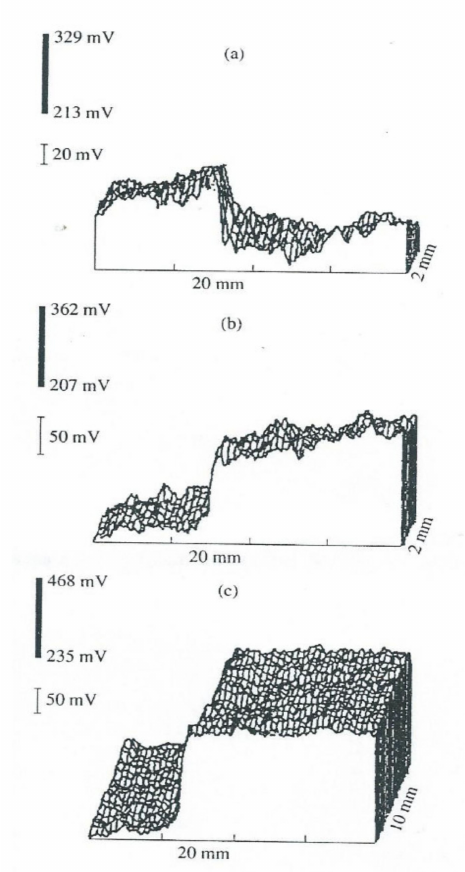
Figure 10. SKP mapping of Fe surface with vapour deposited APTMS (right hand side). ( a )— adsorption in Ar at RH 20%, ( b )—the same surface after exposure in Ar 100% RH, ( c )—the surface with adsorbed APTMS in Ar 100% RH. SKP measurements were performed in ambient air at 60%RH and the potential is given vs. SHE [22]. Published with permission from Pleiades Publishing,